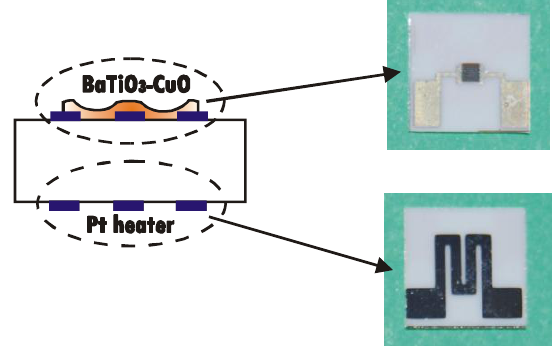
Figure 1. Sensor cross-section and photograph of the final chip (top and back side).